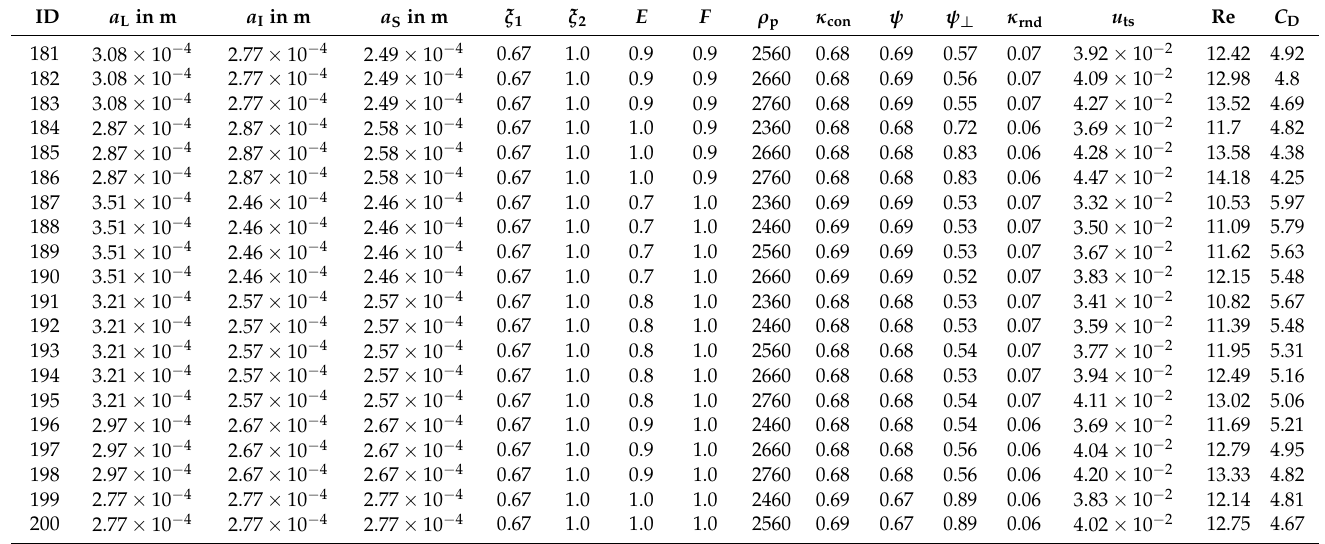
Table A4. Data of the particles in the training set.